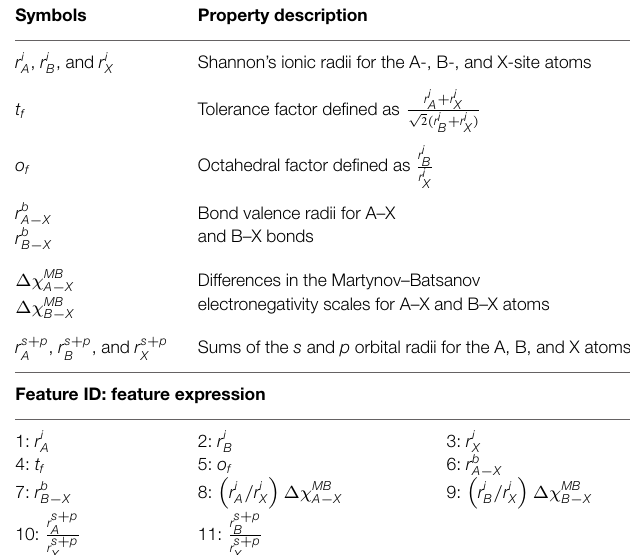
TABLE 1 | A summary of various geometric and electronic properties used in constructing features for the binary classification . Symbols Property description